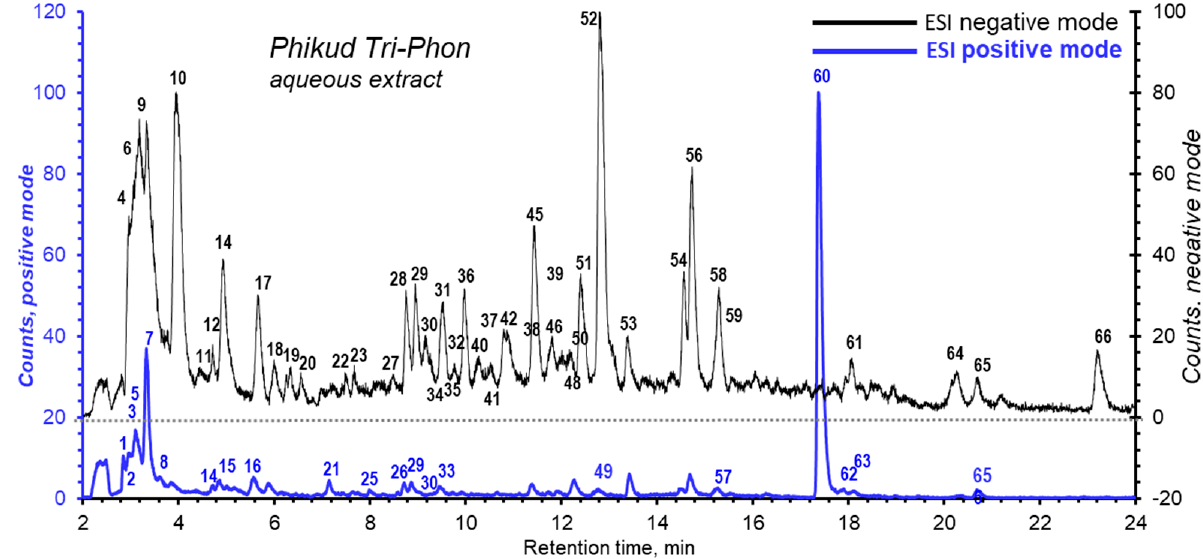
Figure 4. Total ion chromatogram of 10 mg/mL aqueous extract of PTP by LC/MS operated in ESI negative mode and in ESI positive mode. The characteristics of each peak are in Table 3.